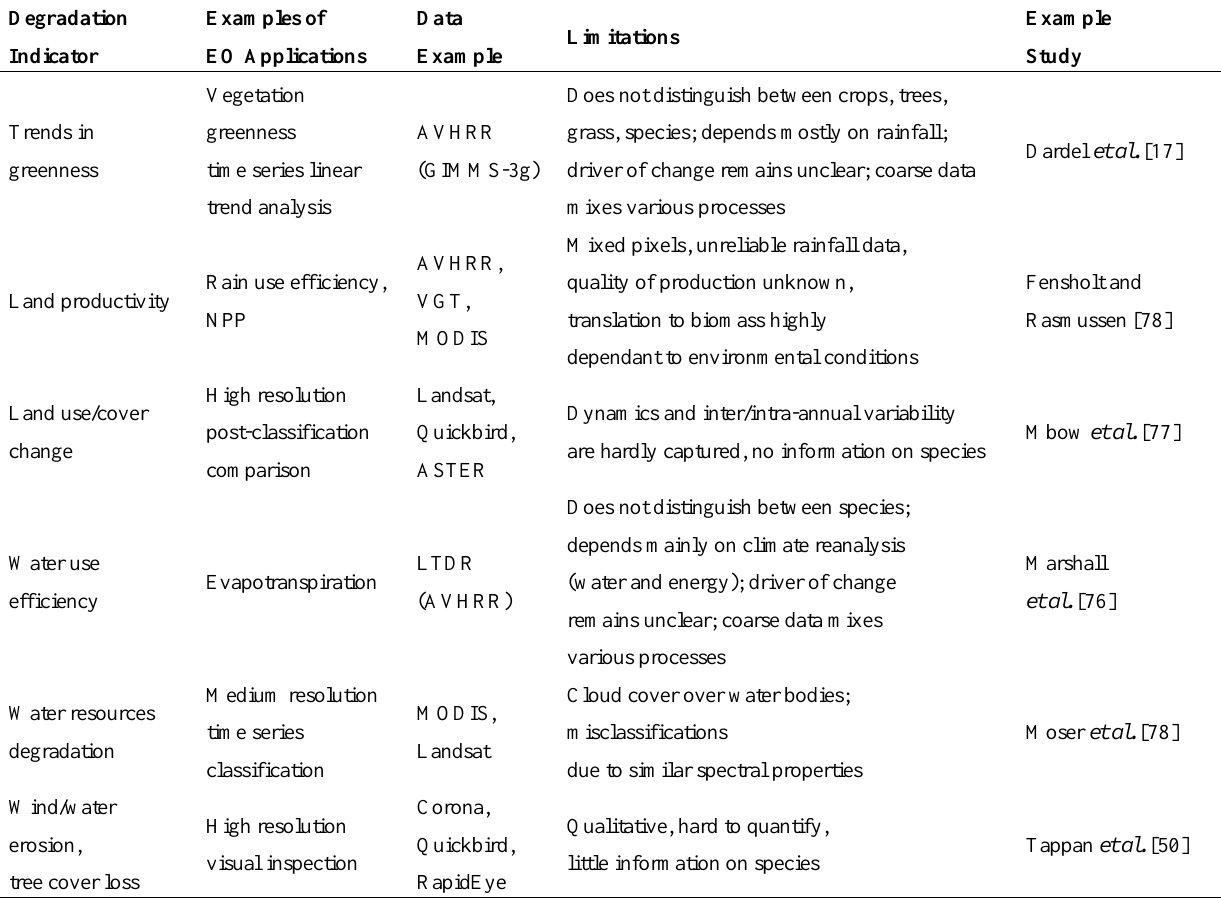
Table 2. Indicators and limitations to monitor land degradation using Earth Observation